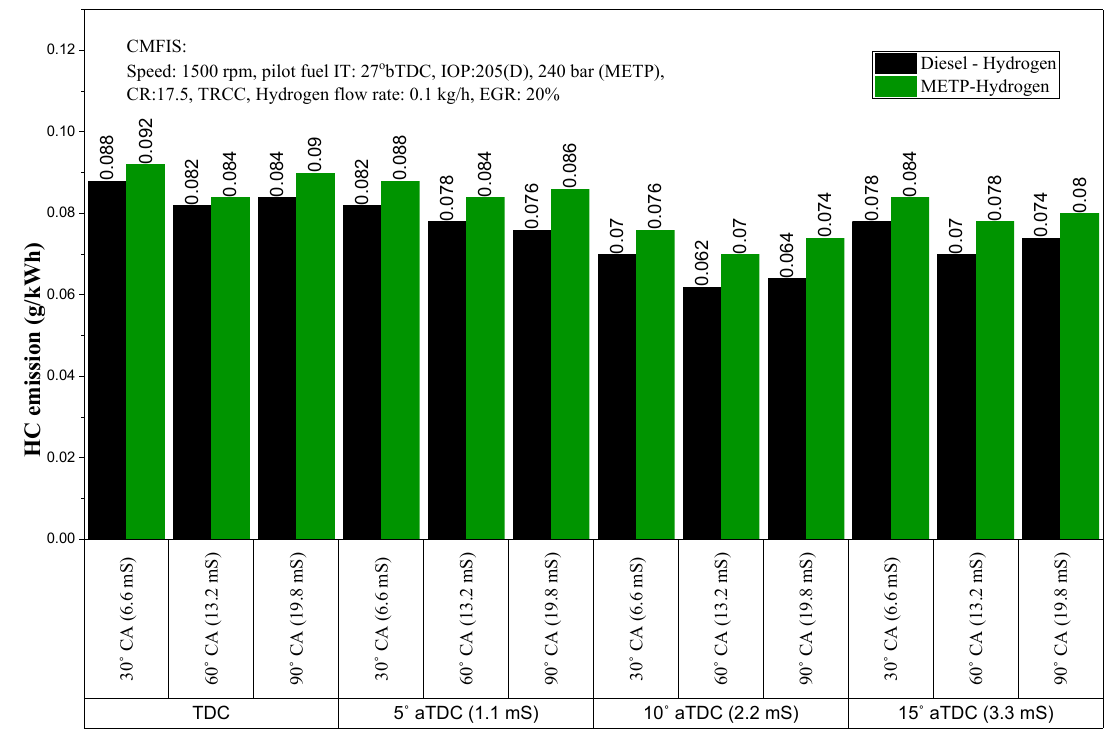
Figure 12. Hydrocarbon (HC) for manifold injection of hydrogen in CMFIS based dual-fuel engine.